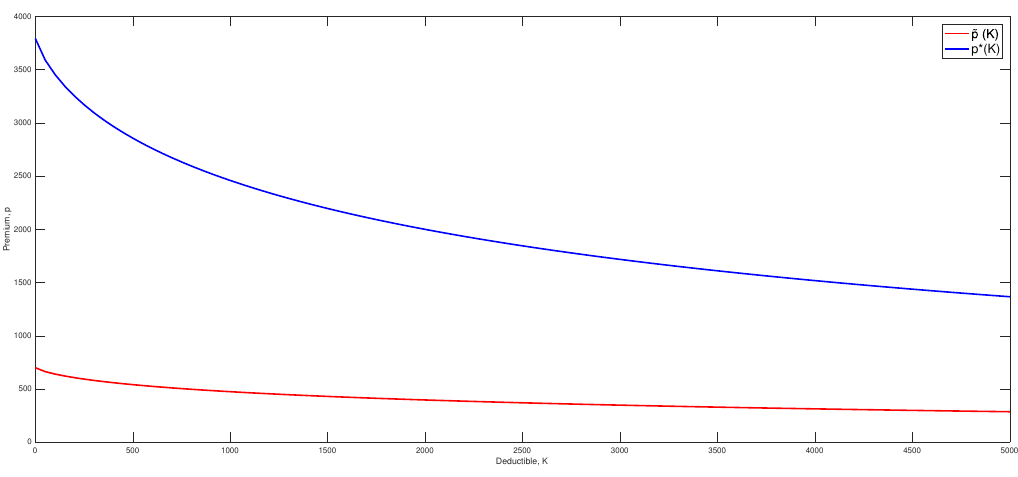
Figure 4. The premiums p ∗ ( K ) and ˜ p ( K ) as functions of the deductible K